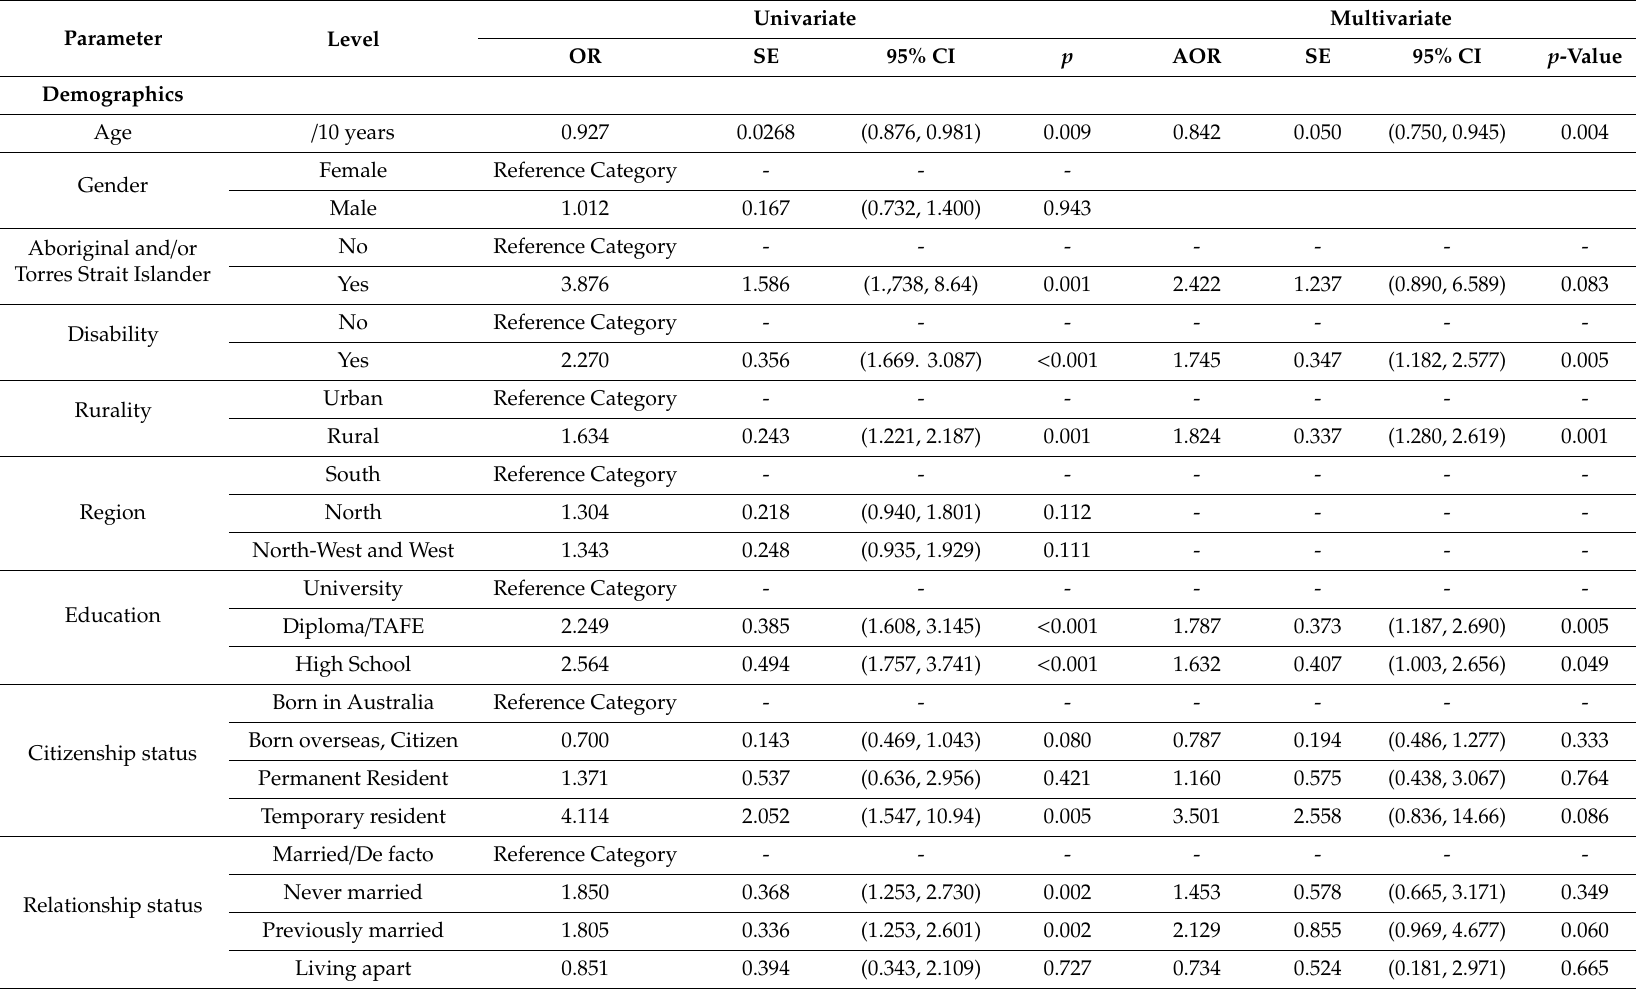
Table 3. Association between risk factors and food insecurity—univariate and multivariate logistic regression. Parameter